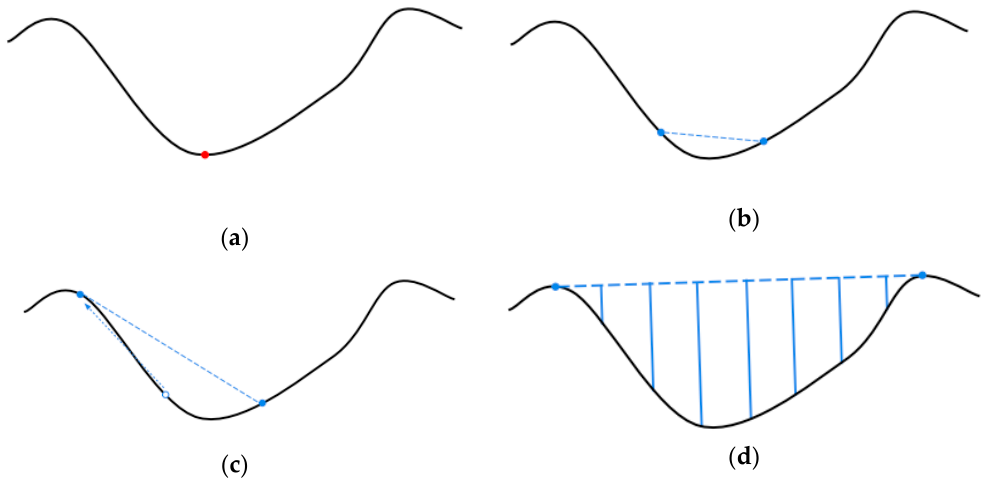
Figure 3. Representing skyline with concavity: ( a ) Find the extreme points of the skyline; ( b ) Set endpoint at initial position; ( c ) Update endpoints iteratively; and ( d ) Coding curves with n-vector.